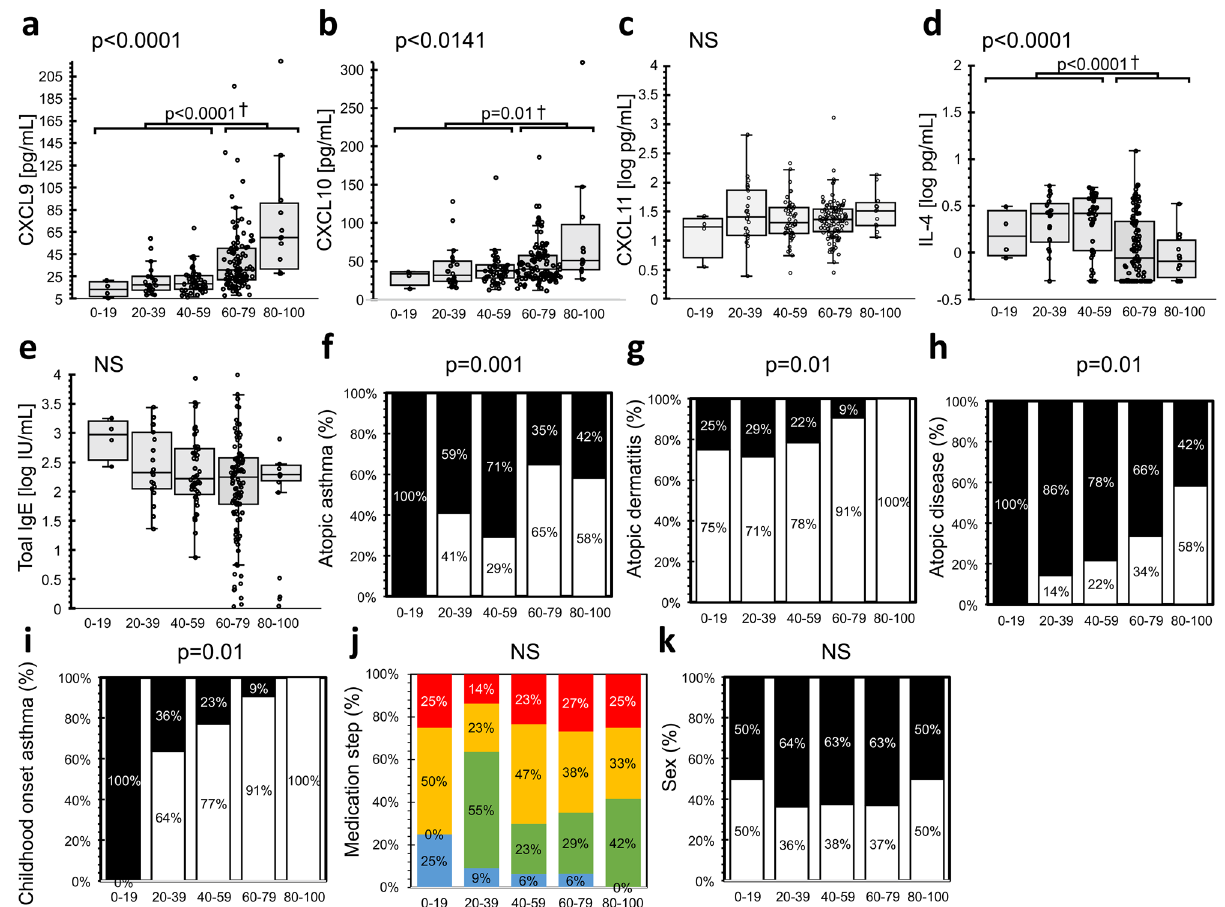
Figure 5. Age-related differences in CXCL9 levels in patients with asthma. Distributions of serum ( a ) CXCL9, ( b ) CXCL10, ( c ) CXCL11, ( d ) IL-4, and ( e ) total IgE levels according to age, which is indicated on the x-axis. Results are shown as individual data points with medians (bars) and interquartile ranges (box). Whiskers extend to the minimum and maximum values excluding outliers. The ratios of ( f ) atopic asthma, ( g ) comorbidity of AD (atopic dermatitis), ( h ) comorbidity of other atopic diseases (AD, atopic rhinitis, atopic conjunctivitis), ( i ) childhood-onset asthma, ( j ) medication steps in JGL2015 (Blue: I, Green: II, Yellow: III, Red: IV) and ( k ) sex are indicated. Filled bars indicate positivity or female for each condition. P-values were calculated using the Steel– Dwass test. *P < 0.05, **P < 0.01, ***P < 0.001, Mann–Whitney U (†) ( a – d ), and Fisher’s exact tests ( f – k